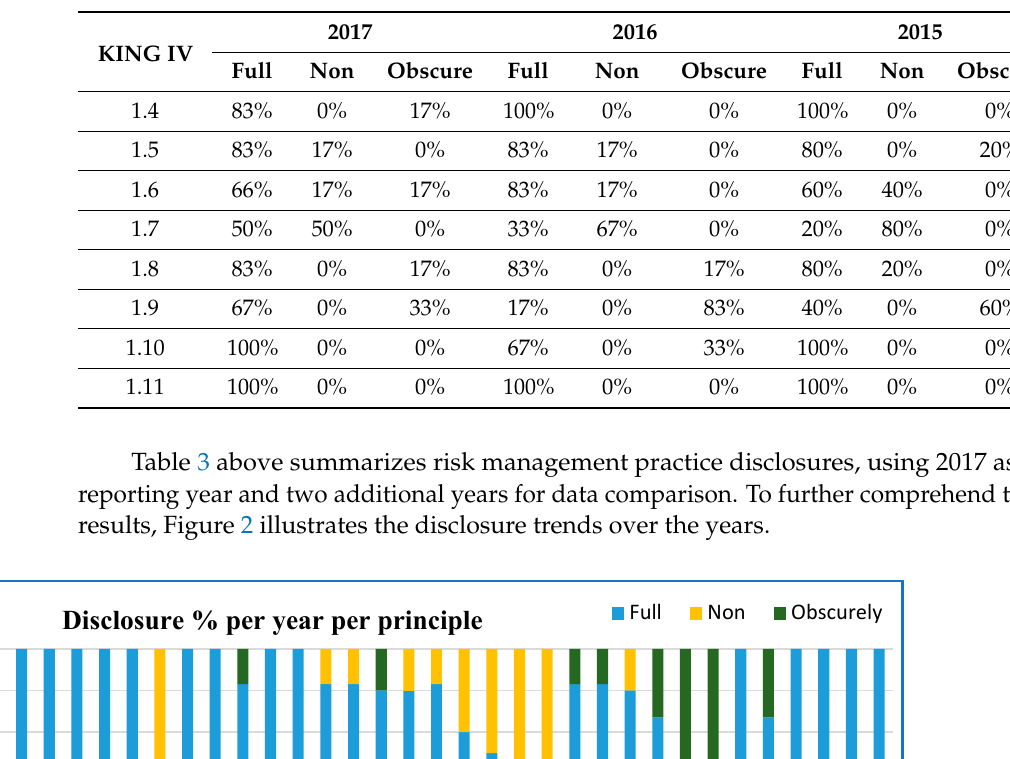
Table 3. Risk management practices disclosures.